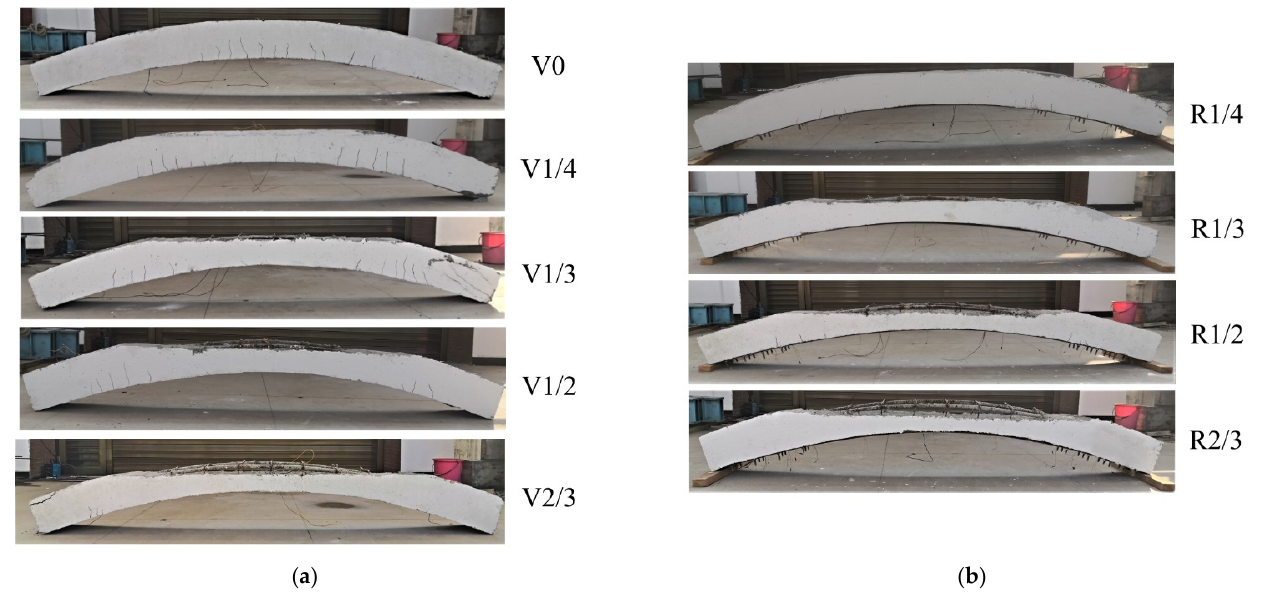
Figure 8. The crack mode in different specimens. ( a ) Unstrengthened specimens; ( b ) Strengthened specimens.